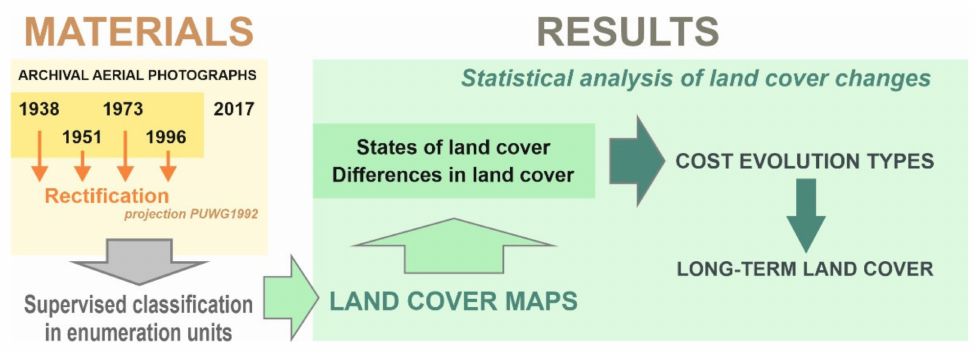
Figure 2. Methodology